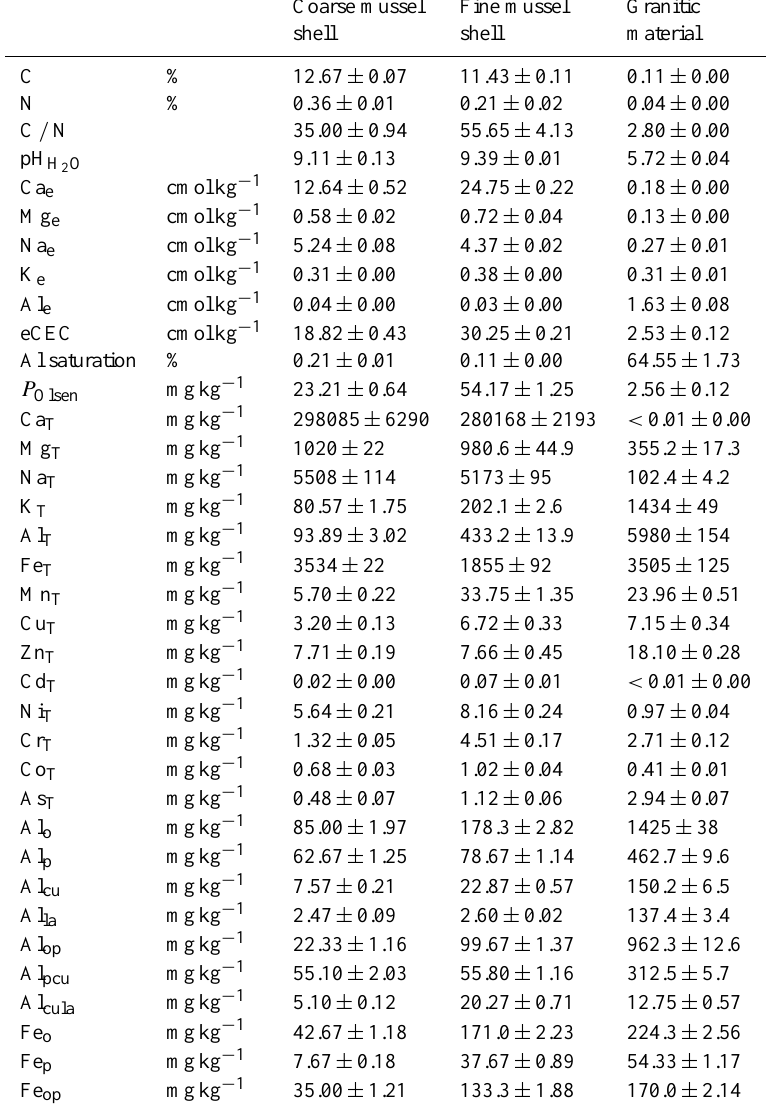
Table 1. General characteristics of the solid materials (average values for three replicates, with coefficients of variation always <